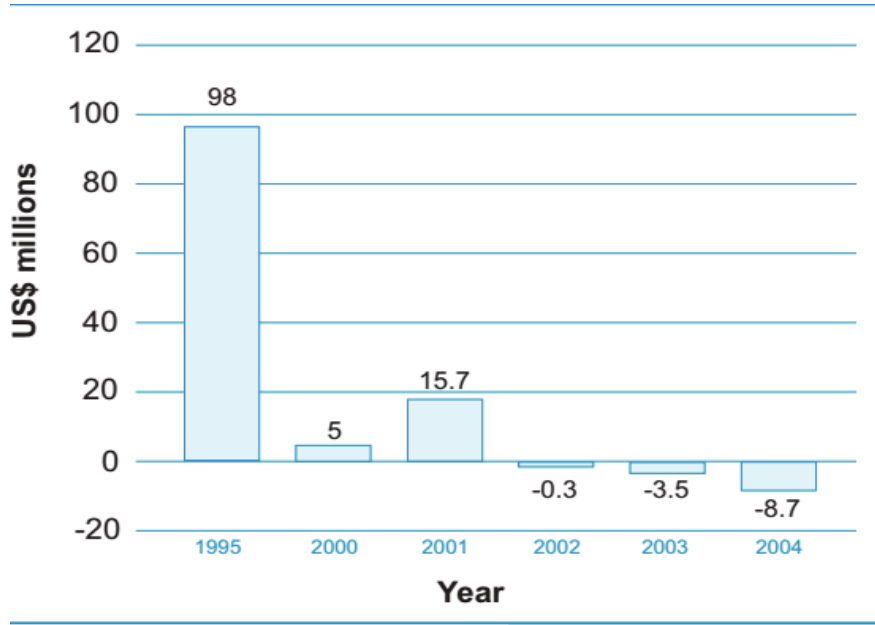
Source: Reserve Bank of Zimbabwe